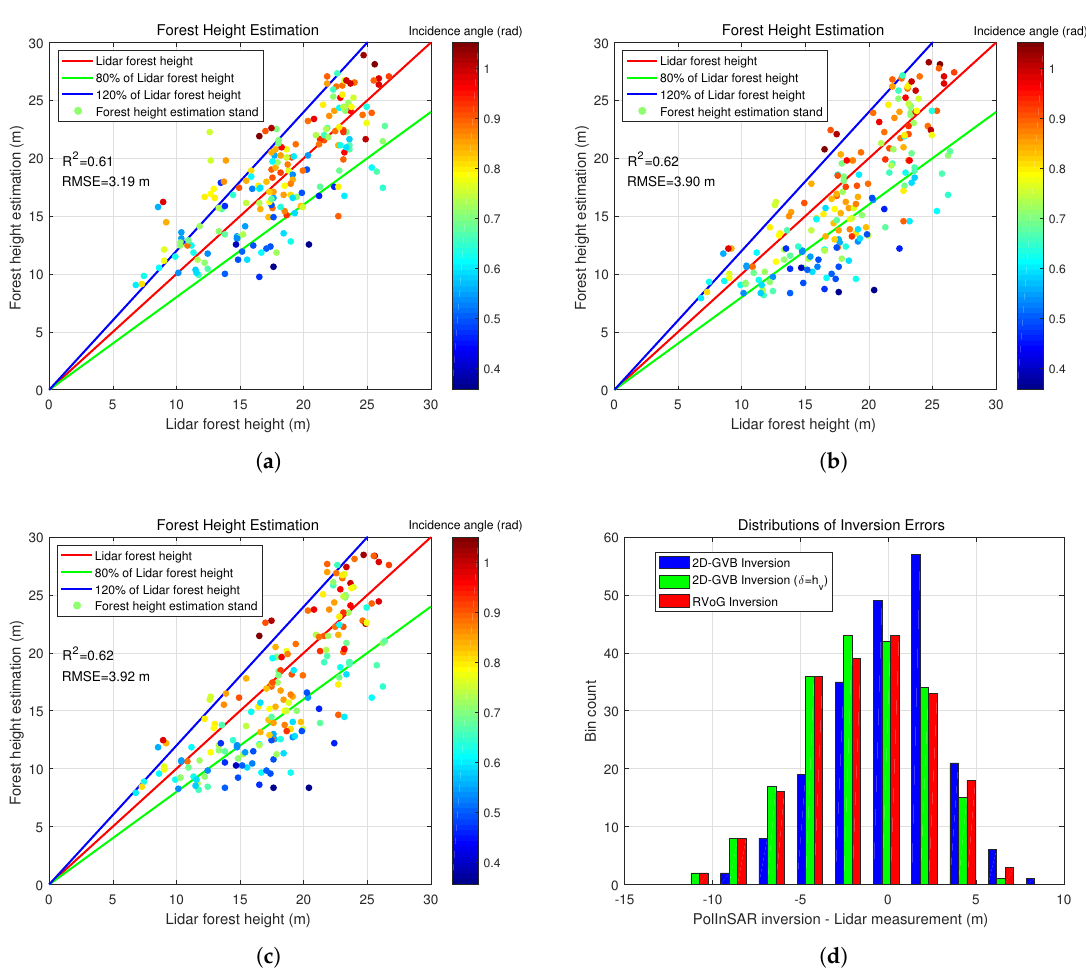
Figure 8. The forest height estimation of validation stands with ( a ) two-dimensional GVB model, ( b ) two-dimensional GVB model with only δ = h v , and ( c ) RVoG model, compared with the LiDAR measurement. The histogram ( d ) shows the differences between the Pol-InSAR inversion and the LiDAR measurement with the two-dimensional GVB model, two-dimensional GVB model with only δ = h v , and RVoG model, respectively. The stands that are counted in ( d ) correspond to the stands in ( a – c